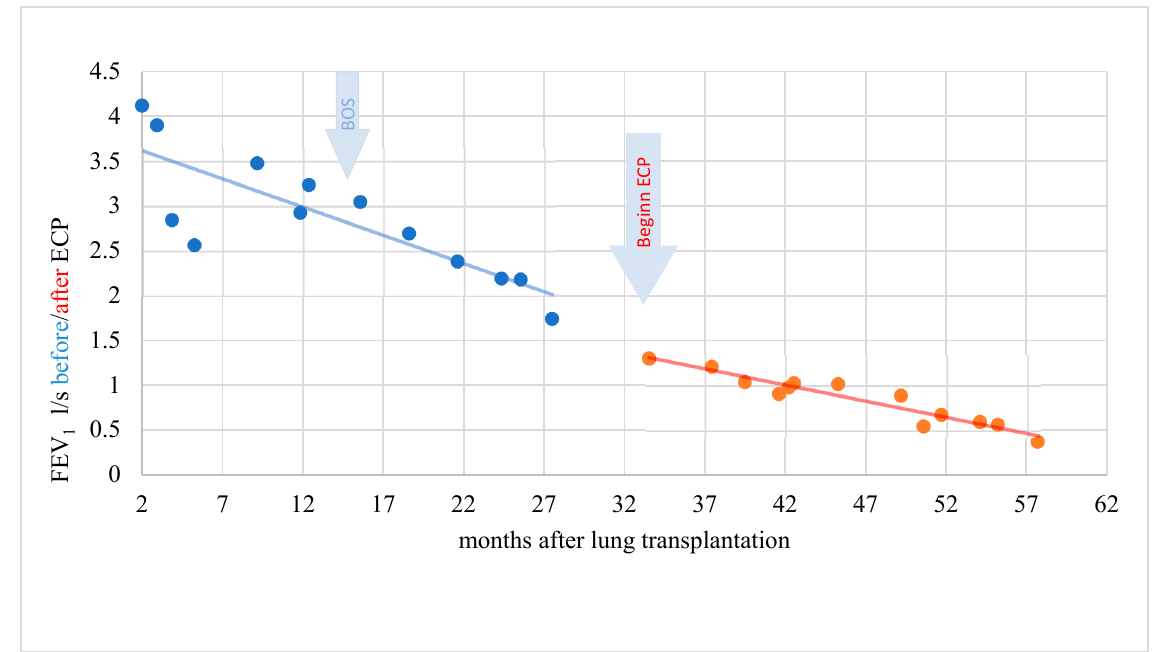
Figure 6. BOS patient without response and decreasing lung function during ECP. The patients' overall treatment responses depending on the BOS stage are shown in In a period of 15 months before the start of ECP, the rapidity of FEV1 reduction was on average–0.229 l/s/month (standard deviation 0.305). A further decline in lung function could be stopped during therapy with ECP and the FEV1 even increased by an average of 0.011 l/s/month (standard deviation 0.049) over a treatment period of 31 months. This difference was statistically significant (t = − 2.346; p = 0.046). In another patient, the rapidity of FEV1 reduction was distinctly reduced under ECP. The difference, however, was not statistically significant (t = − 1.903; p = 0.123) and the response was therefore evaluated clinically objectifiable but statistically not significant (Figure 5).